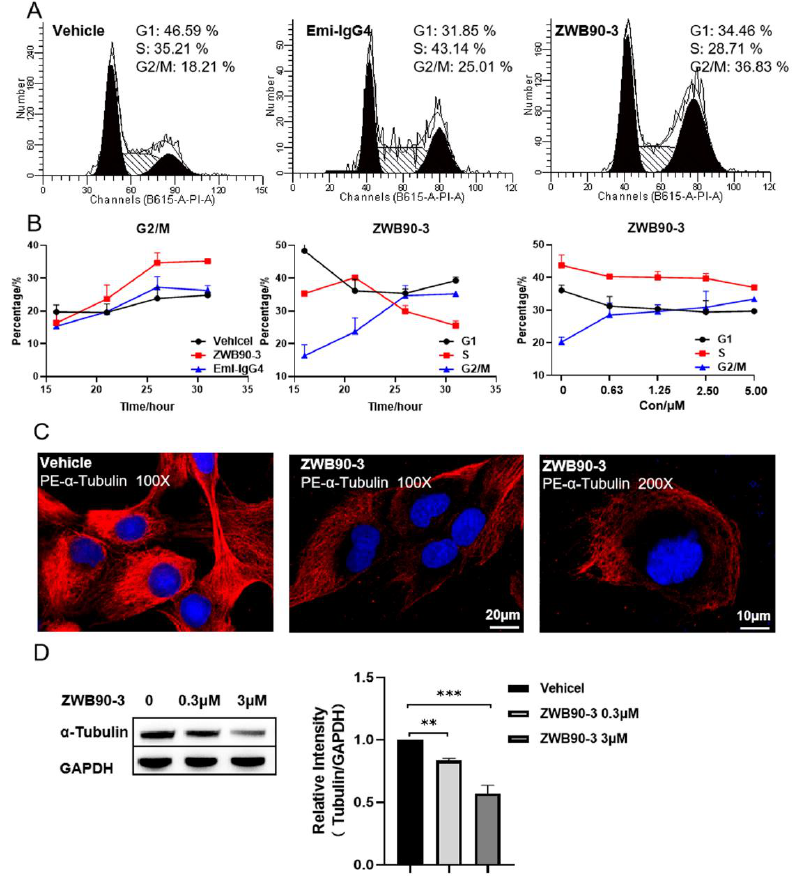
Figure 4. ZWB90-3-induced G2/M-phase arrest and interference in the microtubule arrangement. ( A ) HCC827 cells were treated with PBS (vehicle) or ZWB90-3 or Emi-IgG4 for 26 h, and total DNA